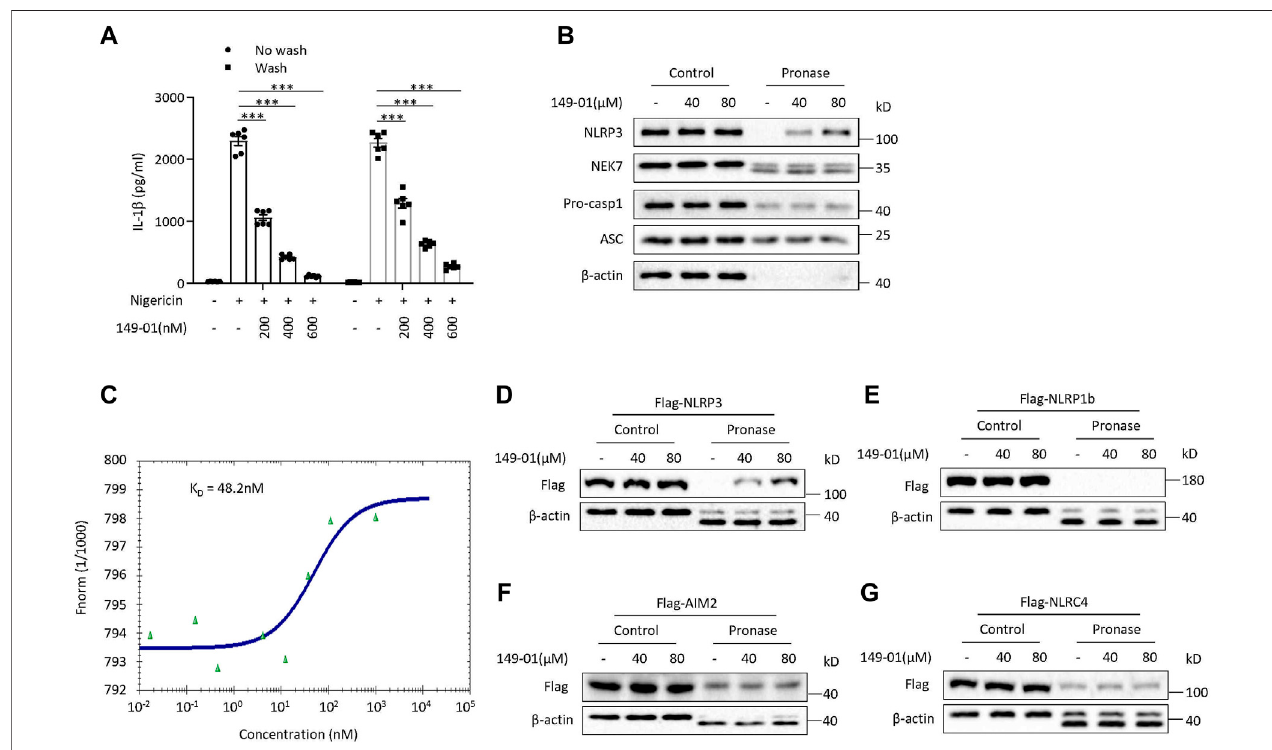
FIGURE4| 149-01irreversibly,directly,andspeci fi callybindstoNLRP3. (A) IL-1 β releasesinsupernatantsfromLPS-primedBMDMstreatedwithindicateddoses of 149-01 for 15 min, washed three times before nigericin stimulation were detected by ELISA. (B) LPS-primed BMDMs cell lysates incubated overnight with indicated doses of 149-01 before pronase digestion were detected by western blot using antibodies for NLRP3, NEK7, pro-caspase-1, ASC and β -actin. (C) Binding af fi nity of 149-01topuri fi edGFP-NLRP3proteinwasanalyzedbyMST.HEK-293TcellstransfectedwithFlag-taggedNLRP3 (D) ,NLRP1b (E) ,AIM2 (F) ,orNLRC4 (G) were lysed and the cell lysates incubated overnight with indicated doses of 149-01 before pronase digestion were detected by western blot. Data are obtained from three independent experiments, each with two biological replicates and are expressed as mean ± s. e.m ( n = 6) (A) , or are representative of three independent experiments (B – G) . One-way ANOVA was applied to calculate statistical signi fi cance: *** p < .001.